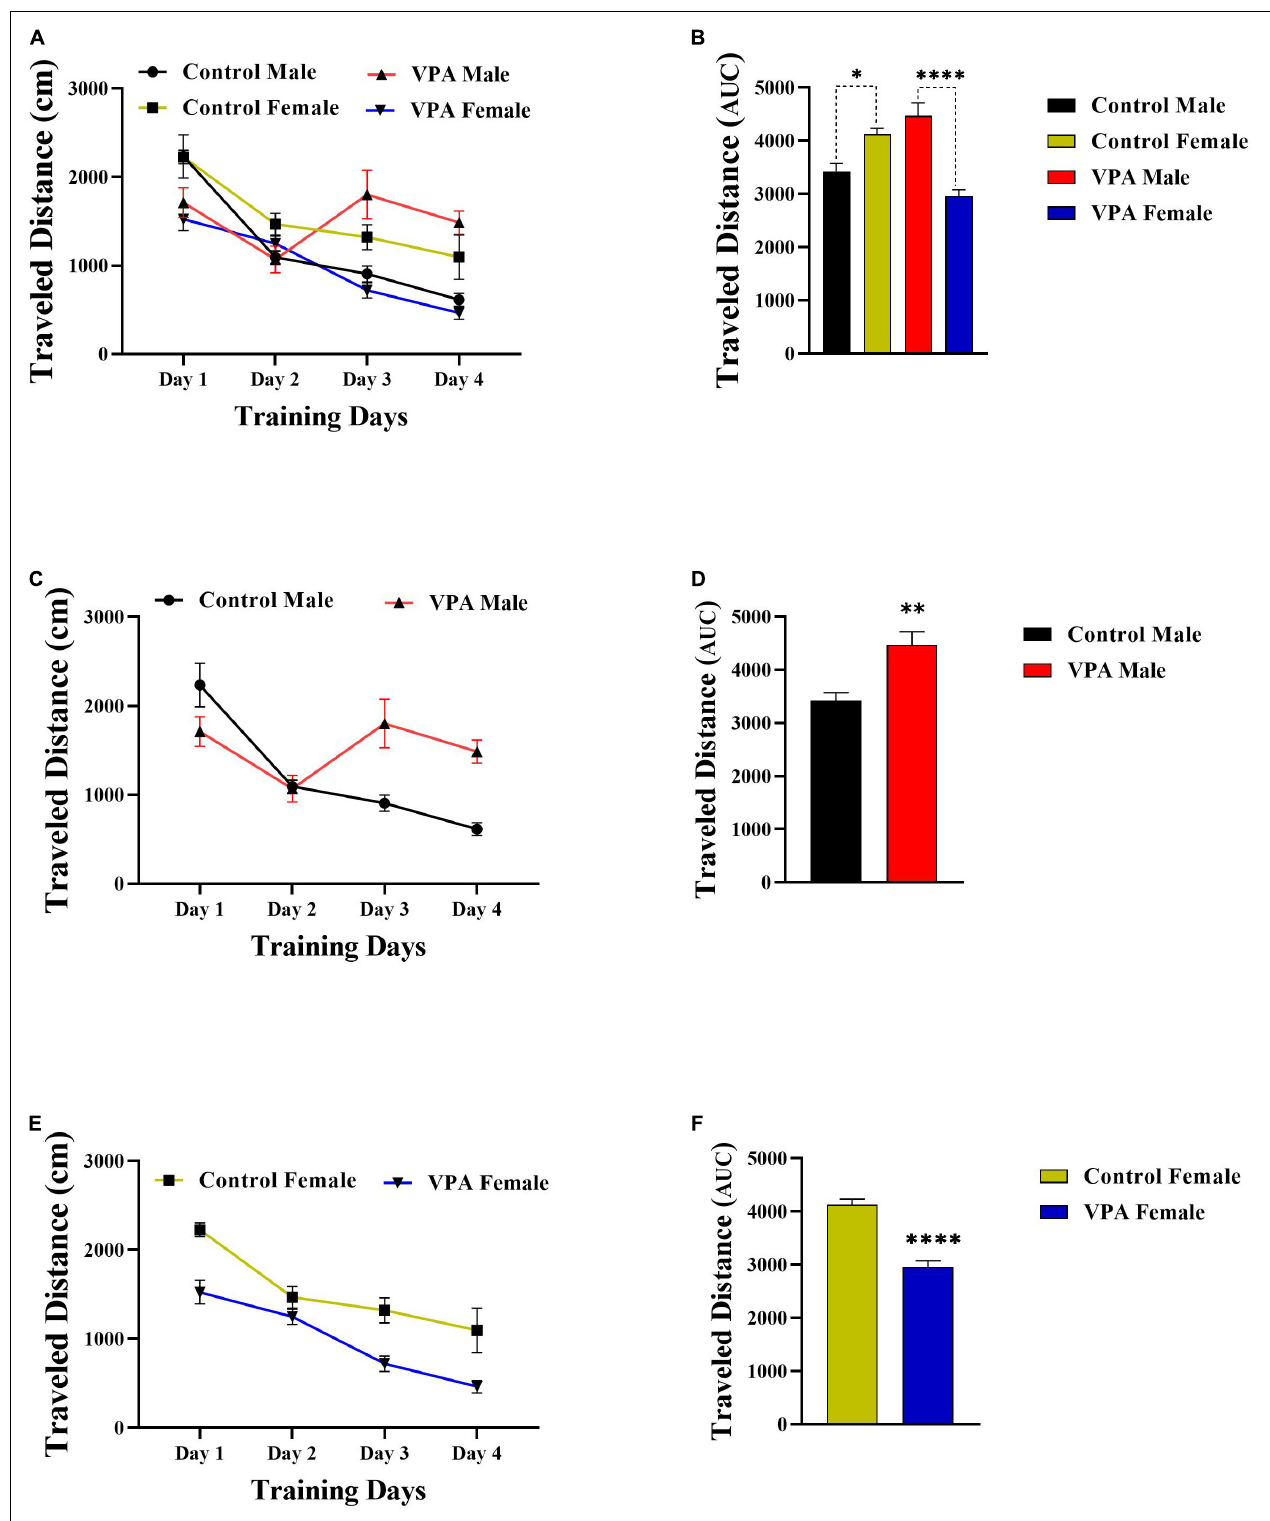
FIGURE 3 | Traveled distance to find the hidden platform during training days. (A) Significant sex differences in the distance traveled in control and VPA-exposed male and female offspring. (B) AUC for traveled distance. (C) Significant differences in the traveled distance in control and VPA-exposed male offspring. (D) AUC for traveled distance in male offsprings. (E,F) Same analysis as (C,D) , respectively, but for female offsprings. Data presented as mean ± SEM. * p < 0.05, ∗∗ p < 0.01, ∗∗∗∗ p < 0.0001.